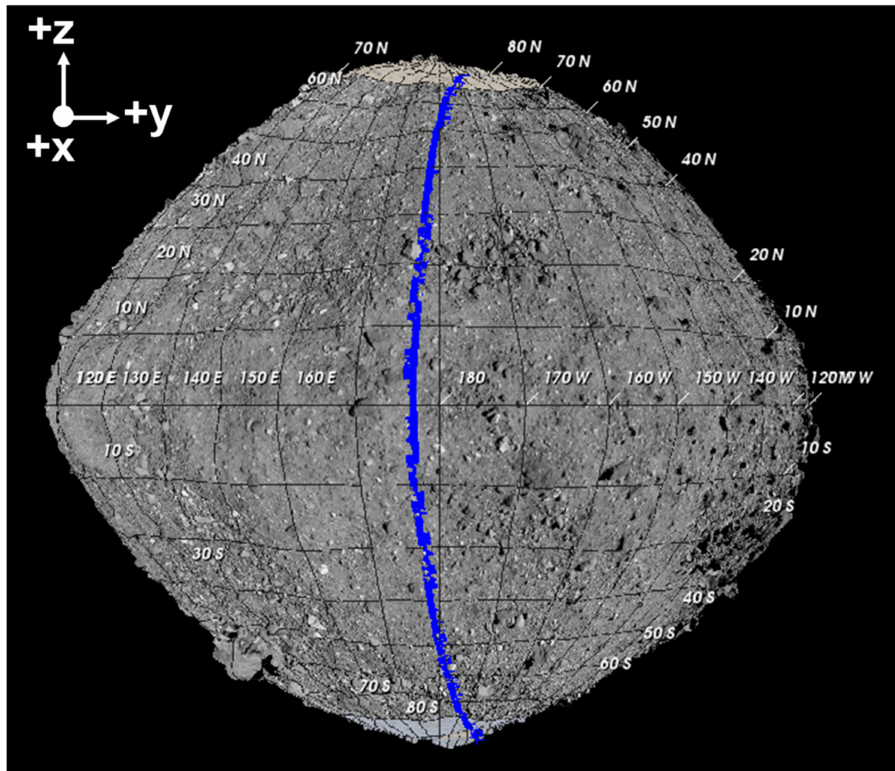
Figure 5. Track location for SALi 101955 orbital simulation on the OLA v20 PTM shape model with a 9 pixel per degree basemap from Bennet et al. (2021) [37]. The ground track location is shown in blue and is ~475 m in length. The track runs from 80.5793 ◦ S and 222.81 ◦ E to 80.99088 ◦ N and 207.642 ◦